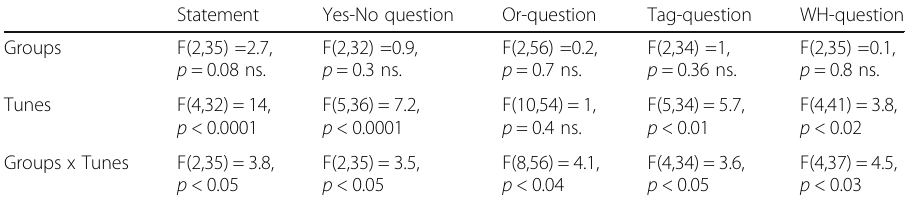
Table 1 Mixed effect model